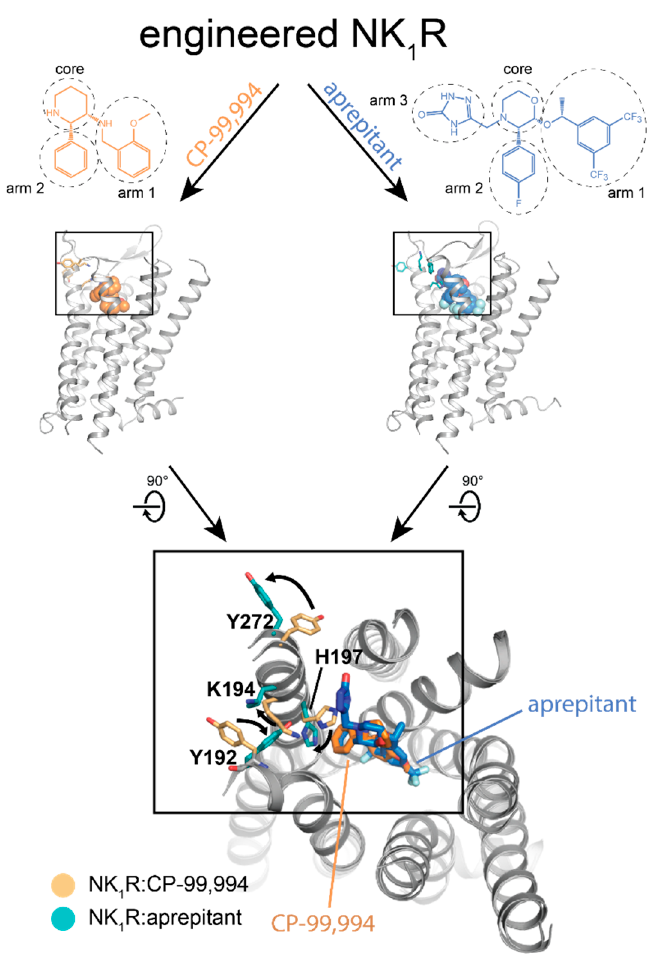
Figure 6. Engineered receptors allow detailed insights into GPCR ligand interactions. Conforma-tional changes explaining insurmountable antagonism of aprepitant. Superposition of NK1R:aprepitant (PDB ID: 6HLO) and NK1R:CP-99,994 (PDB ID: 6HLL). For clarification, black arrows indicate sidechain movements.